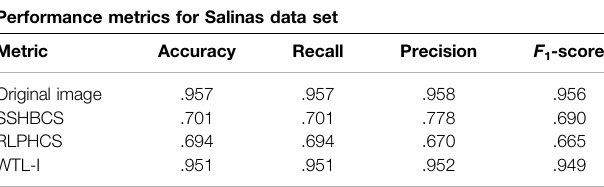
TABLE 4 | Performance of original and reconstructed images. Results are at 20 % SR and 20 dB SNR. Performance metrics for Salinas data